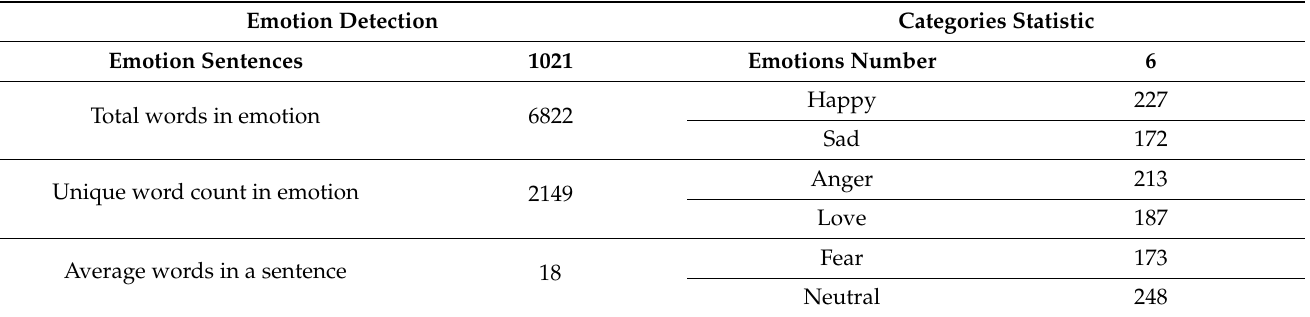
Table 8. Emotion Detection and Sentiment Analysis Dataset Description in terms of Sentence Count. Emotion